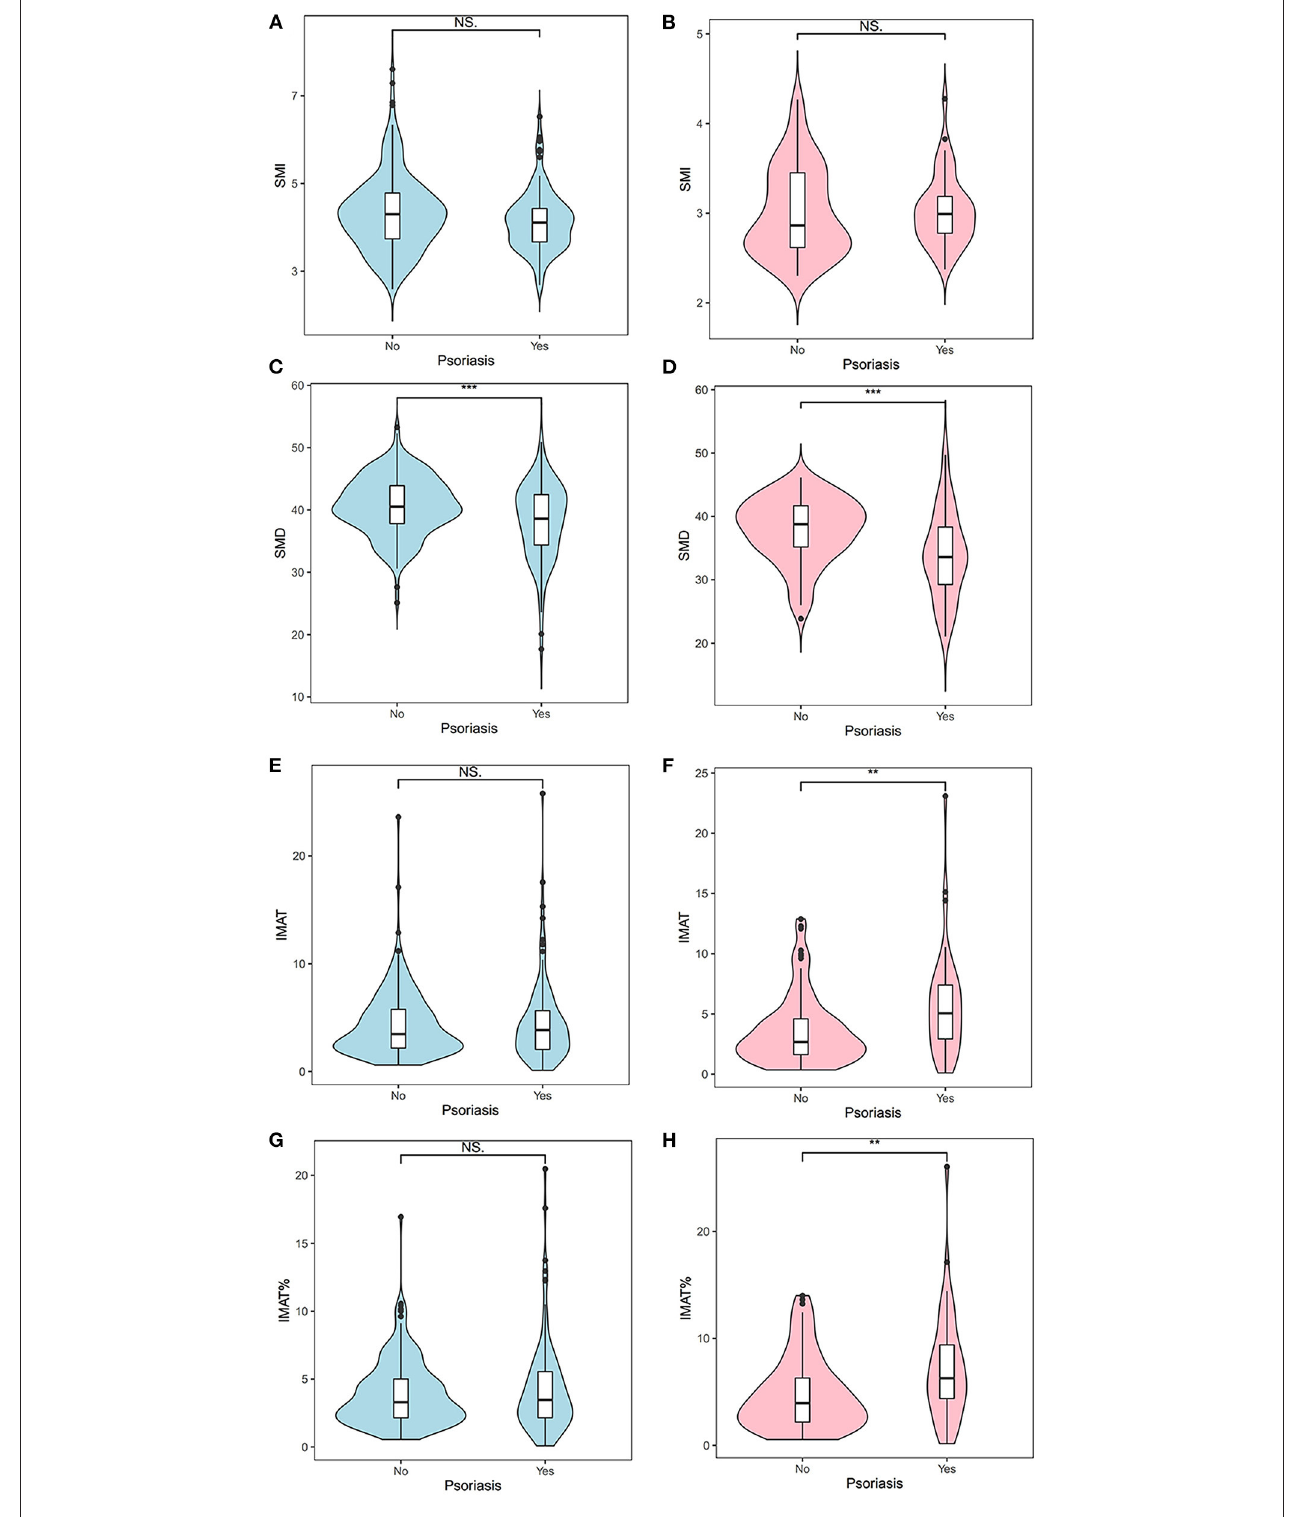
FIGURE 4 | Differences between the psoriasis group and the control group with respect to the SMI (A,B) , SMD (C,D) , IMAT (E,F) , and IMAT% (G,H) . Blue indicates men; pink indicates women. **: < 0.010; ***: < 0.001. IMAT, intermuscular adiposity tissue; IMAT%, percentage of IMAT; NS, not significant; SMD, skeletal muscle radiodensity; SMI, skeletal muscle